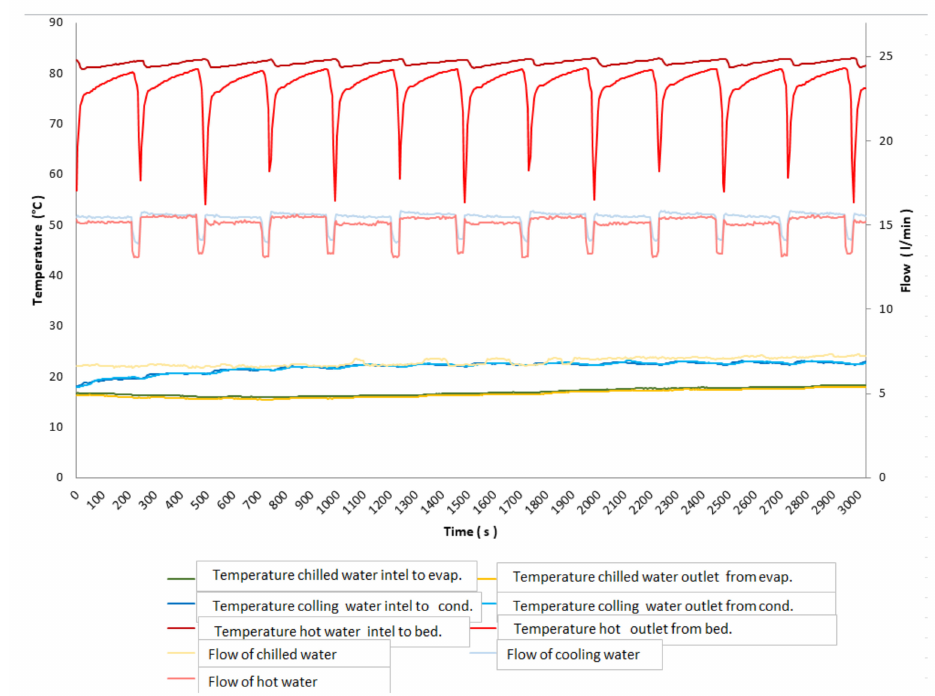
Figure 6. Temperature and water flow rate distribution in the adsorption chiller